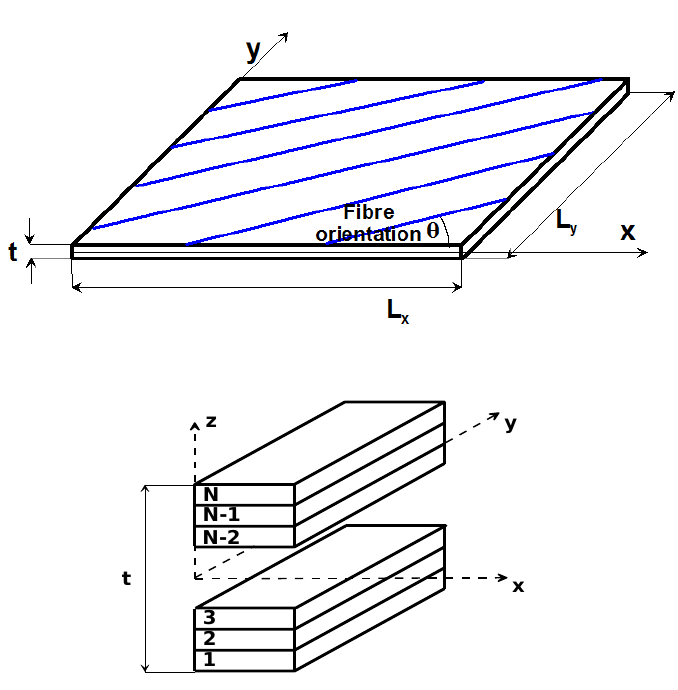
Figure 3. Panel geometry and the stacking sequence.